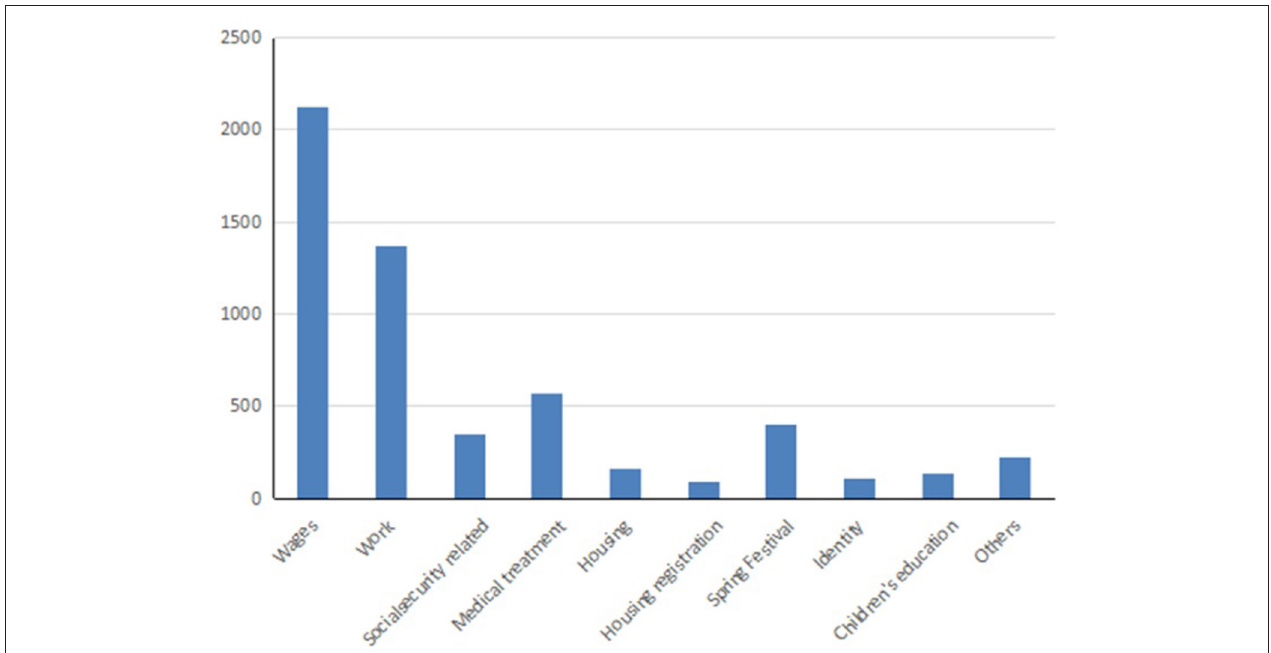
FIGURE 4 | The histogram of distribution of migrant works’ concerns.